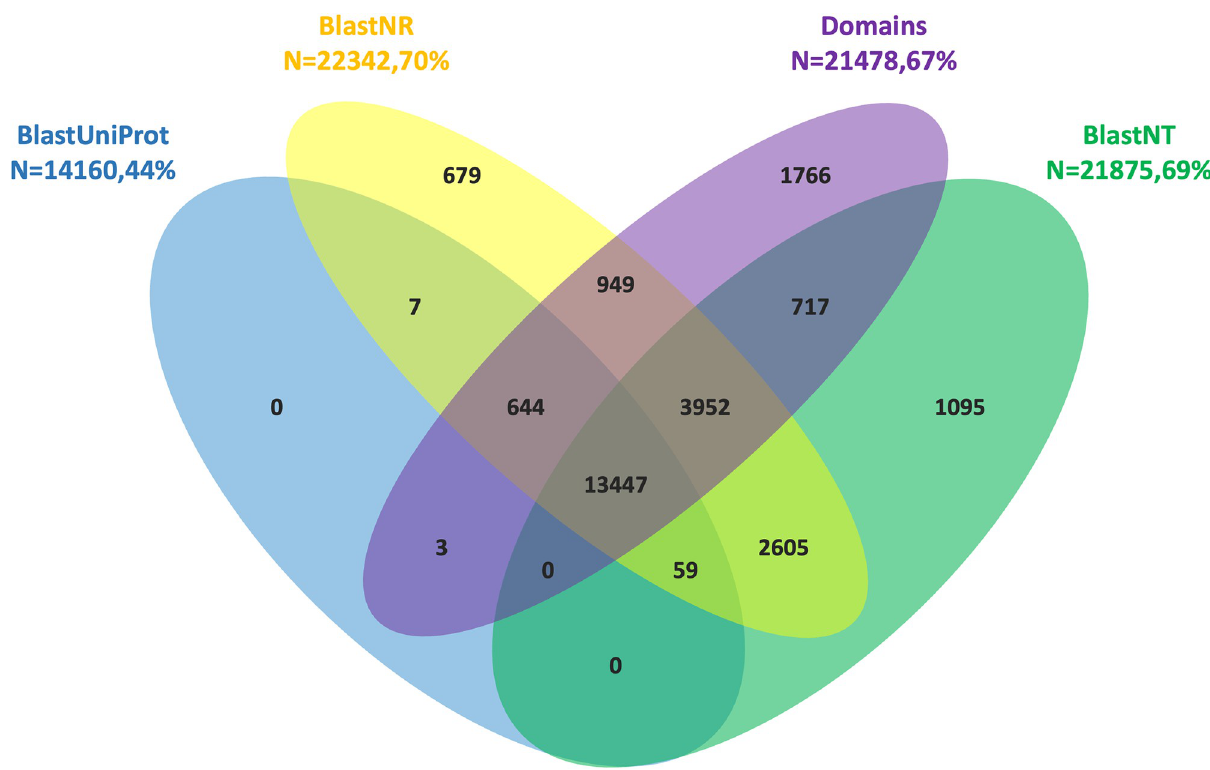
Fig 4. Functional annotation for protein coding gene models predicted in the B . pfeifferi genome.